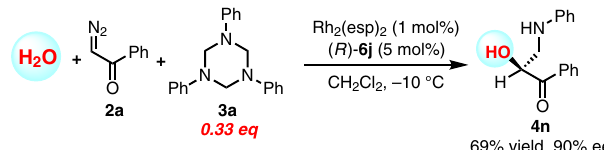
Fig. 6 H 2 O derived three-component aminomethylation. Using water as nucleophile to directly afford O -unprotected β -amino- α -hydroxy ketone.